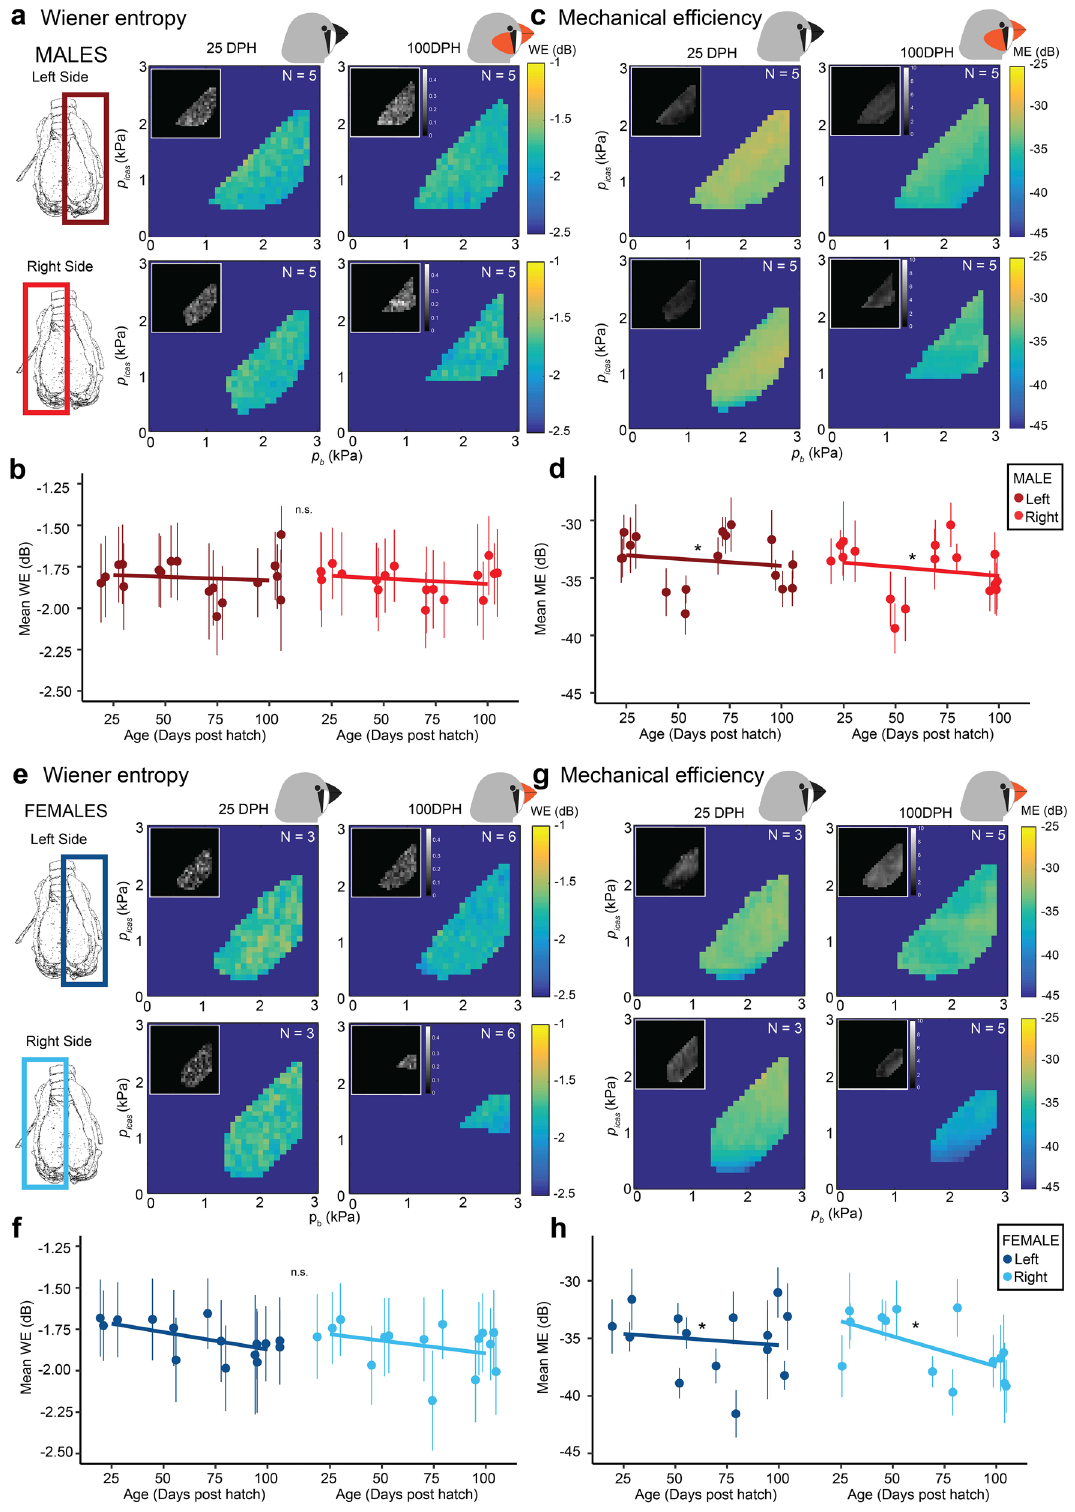
Figure 7. Wiener entropy and mechanical efficiency do not change over zebra finch song development. ( a ) In males, Wiener entropy (WE) for the left and right hemi-syrinx in males age 25 and 100 DPH. ( b ) WE did not change for males over development. ( c ) Mechanical efficiency (ME) for the left and right hemi-syrinx in males age 25 and 100 DPH. ( d ) The mean ME produced for males significantly differed over development. ( e ) In females, WE did not significantly change over development. ( f ) WE did not change for females over development. ( g ) Mechanical efficiency (ME) for the left and right hemi-syrinx in females age 25 and 100 DPH. ( h ) The mean ME of female syrinxes decreased significantly over development. For statistics see Supplementary Table S2. *p <